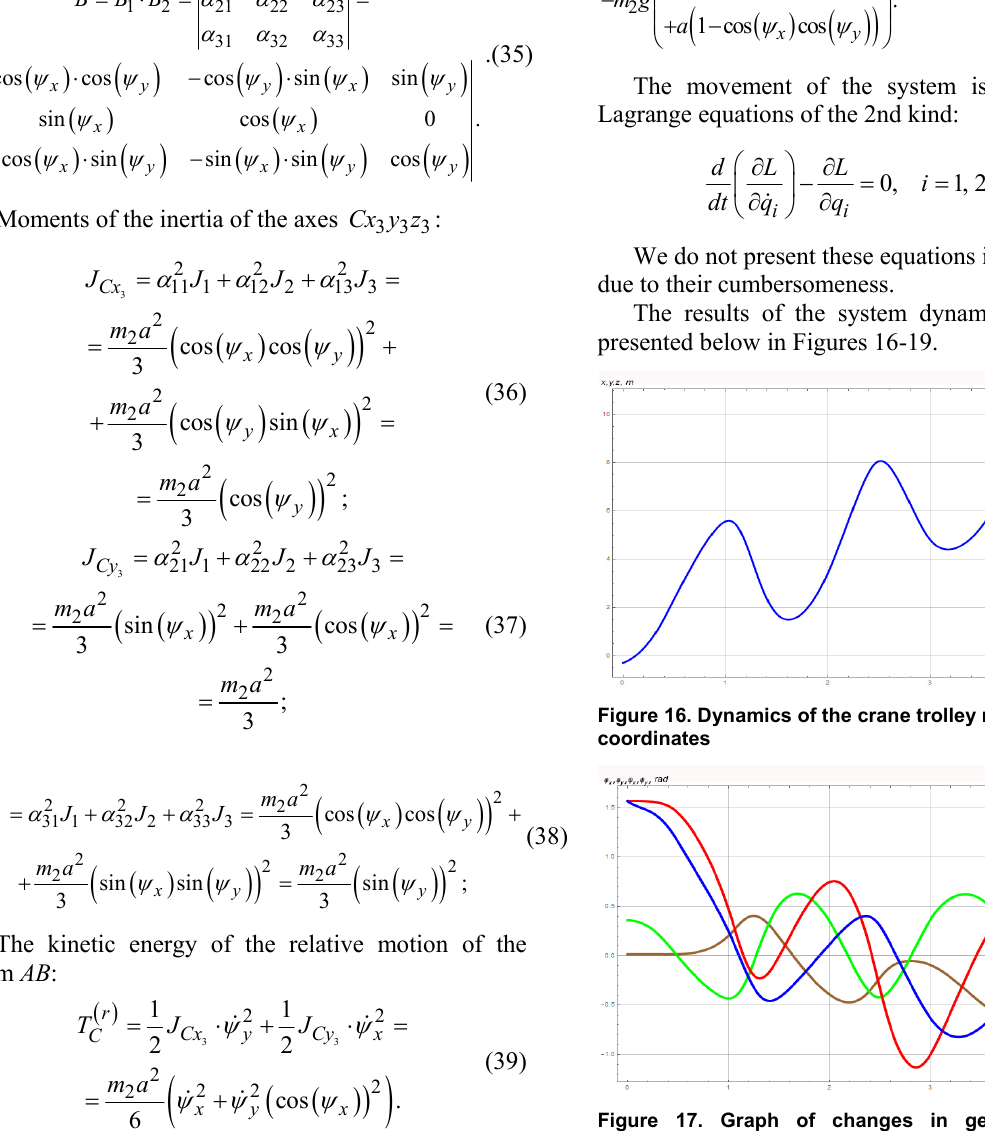
Figure 17. Graph of changes in generalized angular